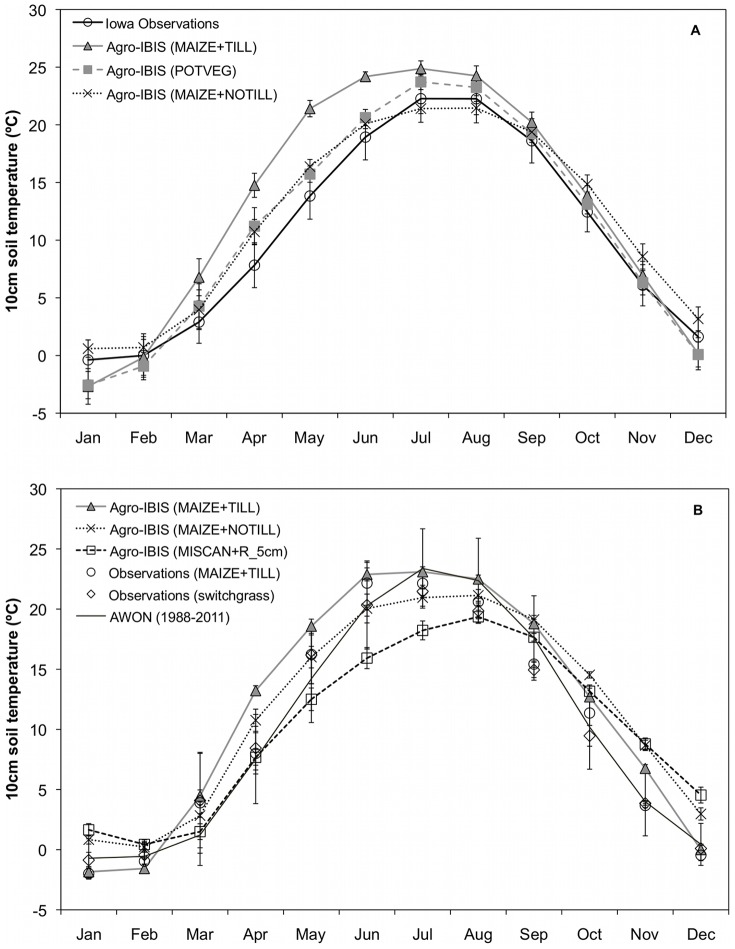
Comparison of observed and simulated soil temperatures in Iowa and Wisconsin.(a) Comparison of monthly average 10 cm soil temperatures for three Agro-IBIS model simulations with observational station data from Hu and Feng (2003) averaged over the state of Iowa for 1982–2002. Error bars are ±1 S.E. for both simulated and observed values. (b) Comparison of monthly average 10 cm soil temperatures for three Agro-IBIS models simulations compared with observational data at the University of Wisconsin-Madison Arlington Agricultural Research Station in tilled maize and switchgrass study plots for July 2009- June 2012. Observed data (maize and switchgrass) represent the monthly mean among 3 replicate plots (n = 3). Long-term averages (1988–2011) of monthly mean 10 cm soil temperature collected at the UW-Madison Automated Weather Observing Network (AWON) site at Arlington are plotted for comparison. Error bars are ±1 S.E. for all simulated and observed values.